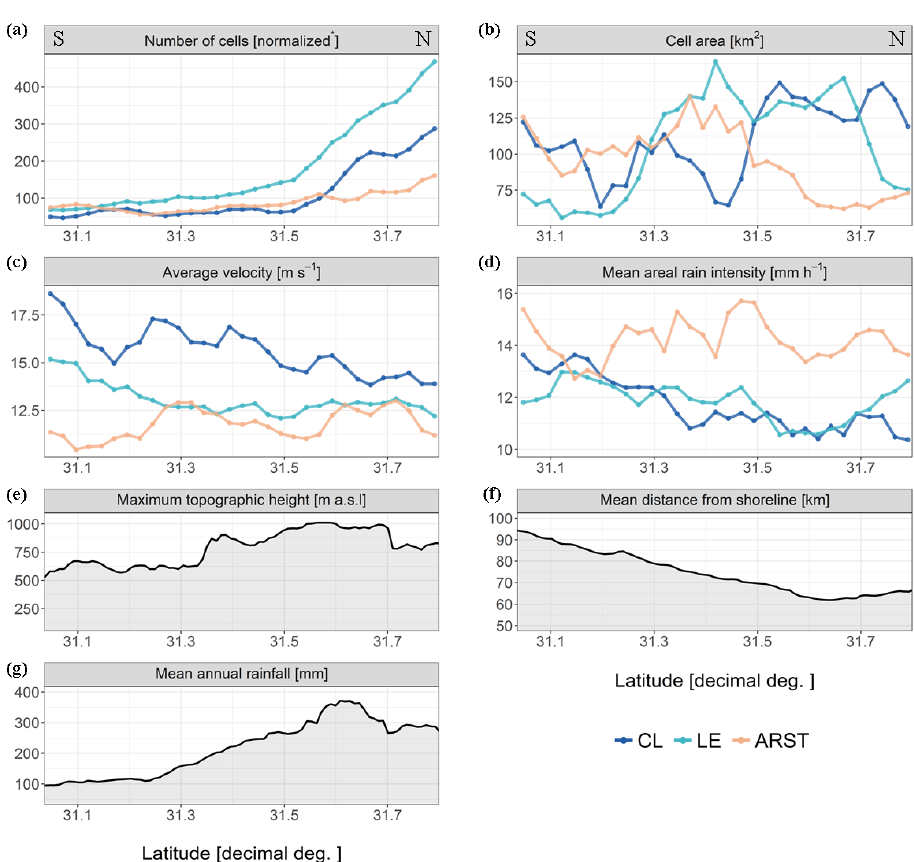
Figure 8. Mean rain-cell properties along a north–south (right-to-left axes) orientation of the different synoptic systems: (a) number of cells 1 , (b) cell area (km 2 ), (c) average velocity (ms − 1 ), (d) mean areal rain intensity (mmh − 1 ). Potentially related variables along the same axis: (e) maximal topographic height (ma.s.l.), (f) distance from shoreline (km), and (g) mean annual rainfall (mm). Each point represents the mean or maximal value in a west to east strip (in panels a–d , the strip is 2.5km wide and a running average of 7.5 km is